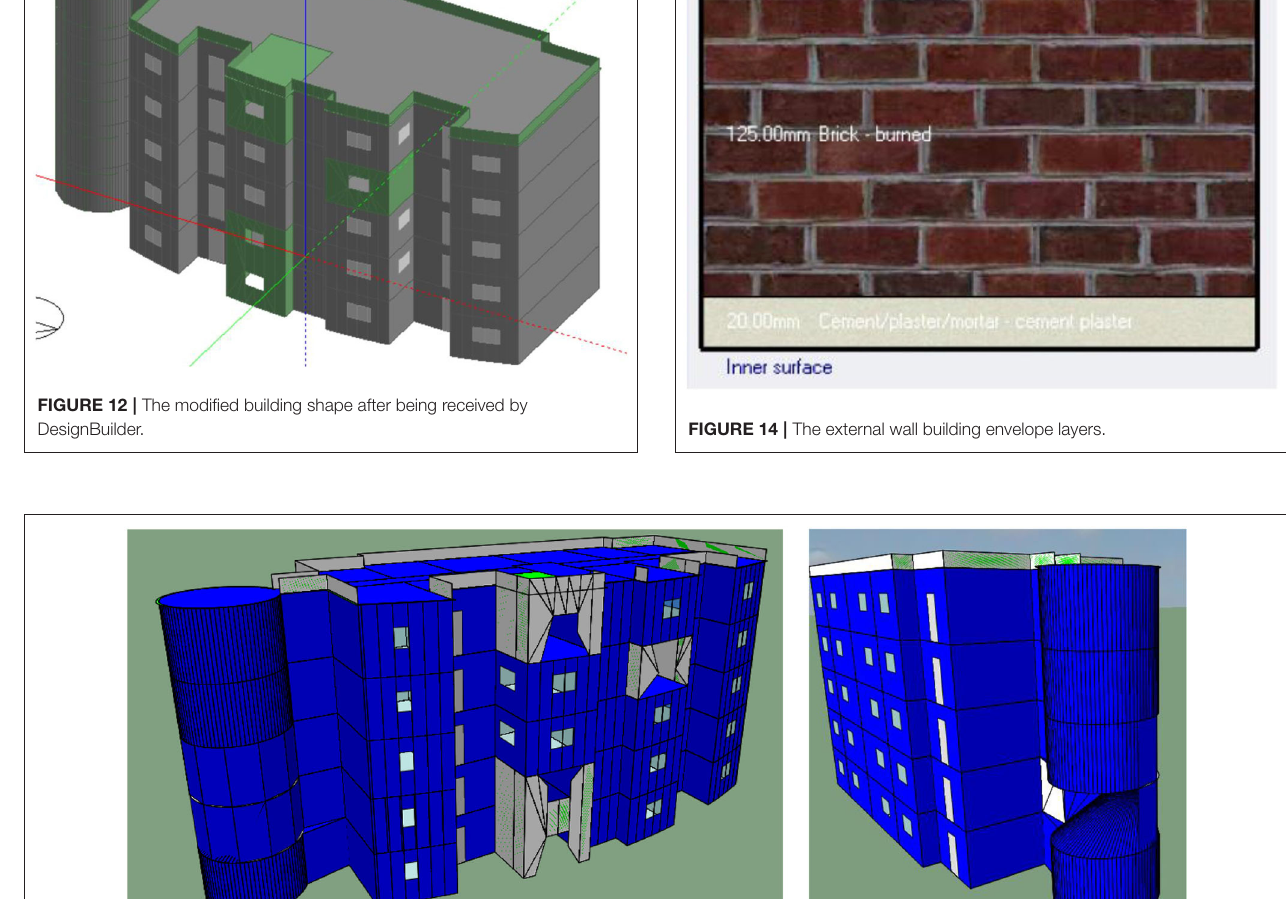
Frontiers in Built Environment |